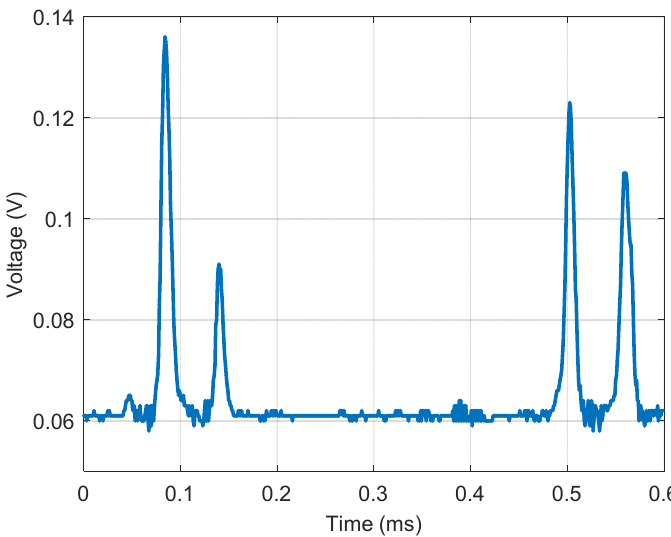
Figure 12. Raw signal acquired for a transparent film; nominal thickness 50 μ m.